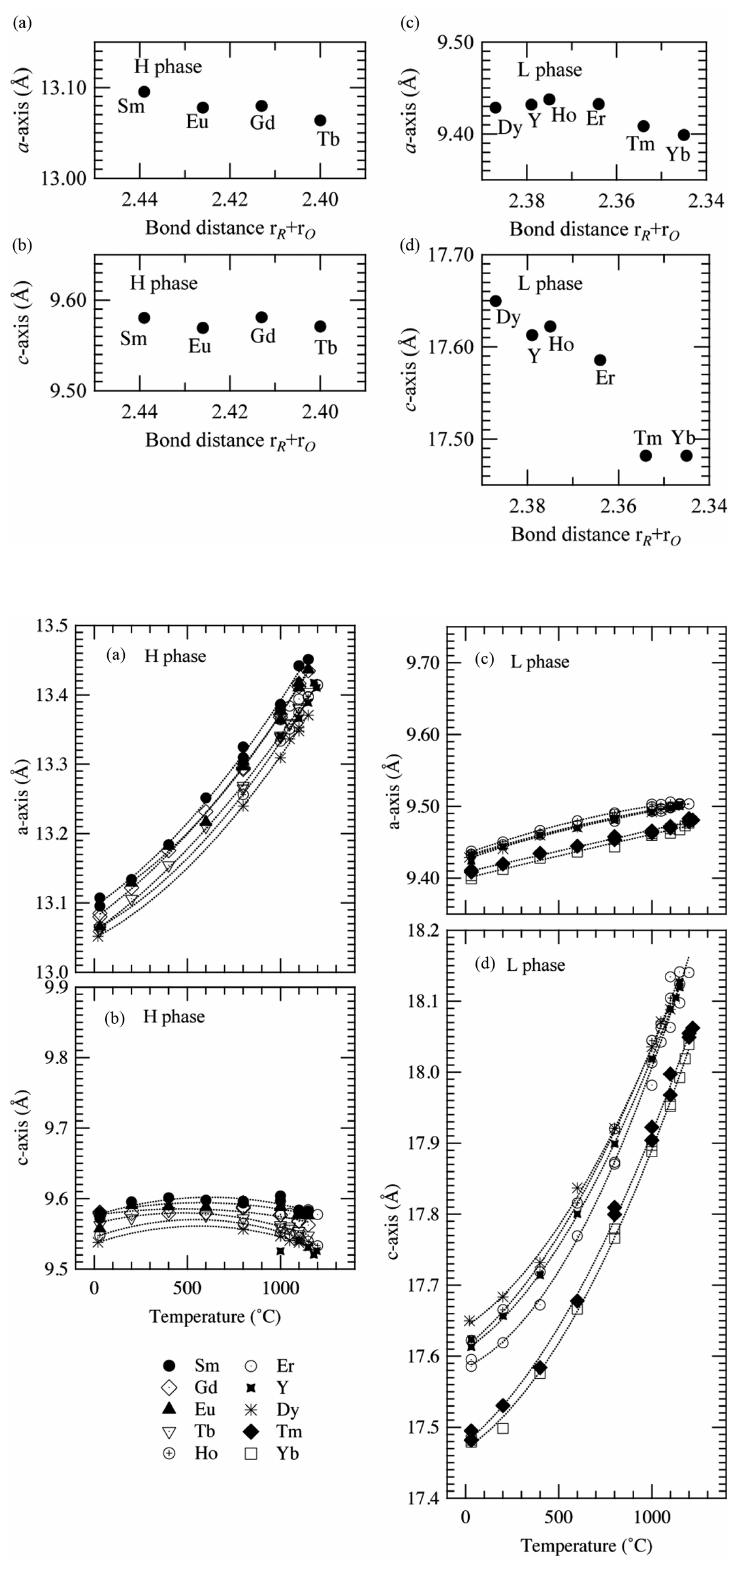
Figure 5: Temperature dependence of the unit cell parameters; (a) a - and (b) c -axes of the H phase, and (c) a - and (d) c -axes of the L phase. Dotted lines are the fitted quadratic curves. Fitted coefficients are shown in Table 1.